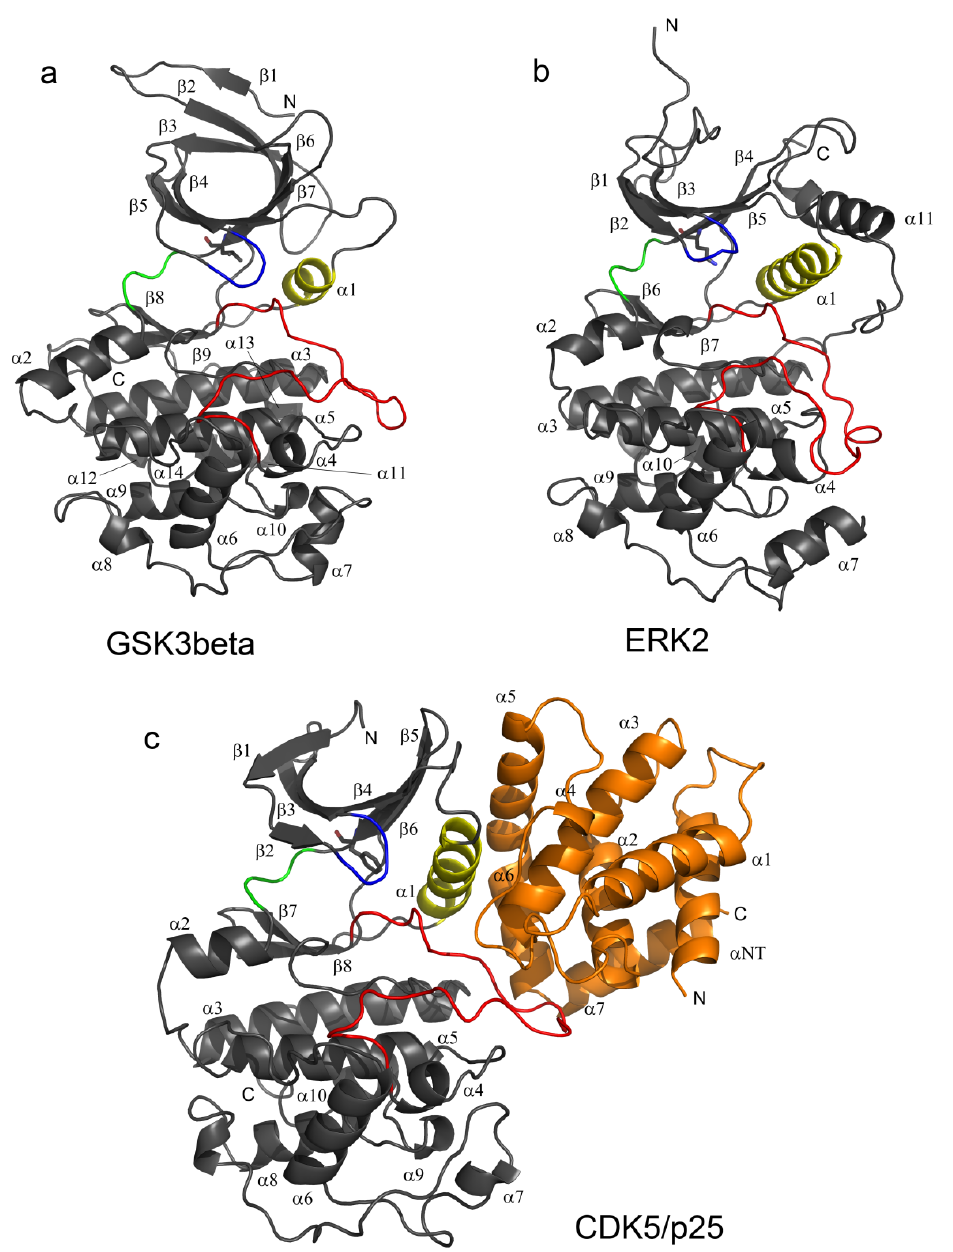
Figure 1. Kinases are shown as secondary structure cartoons representations (grey). Common structural features are colour coded as follows: PSTAIRE/helix α C, yellow; activation loop (T-loop), red; hinge region, green; Gly-rich loop (P-loop), blue. The gate-keeper residue in represented in CPK (Corey-Pauling-Koltun) sticks. The three modelled structures are ( a ) GSK3 β ( b ) ERK2 and ( c ) CDK5/p25, p25 depicted in